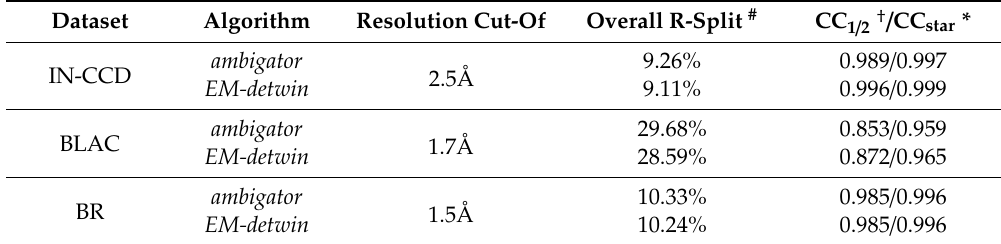
Table 4. Merging consistency comparison.